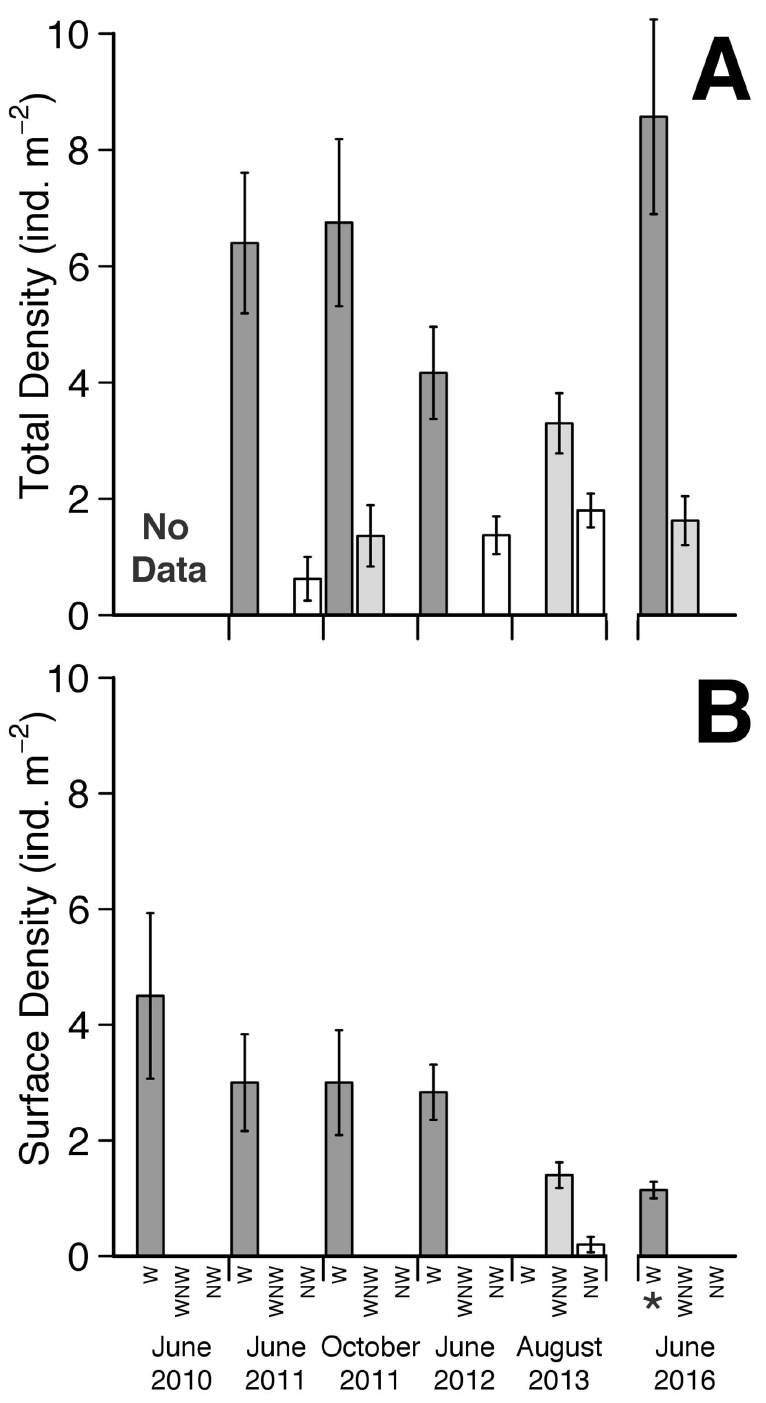
Fig 2. Bar plots of mean ( ± 1standard error of the mean, SE) Mercenaria mercenaria density versus site/walking designation in Orient Harbor, New York, USA. (A) Total (epibenthic+ endobenthic) clam density. (B) Surface (epibenthic) clam density. All densitiesquantifiedat the East Marion site, except where noted as * (= Peter’s Neck site). W = walkingclams, in ‘walking’areas; NW = non-walking clams, in ‘non- walking’area; WNW = non-walking clams in